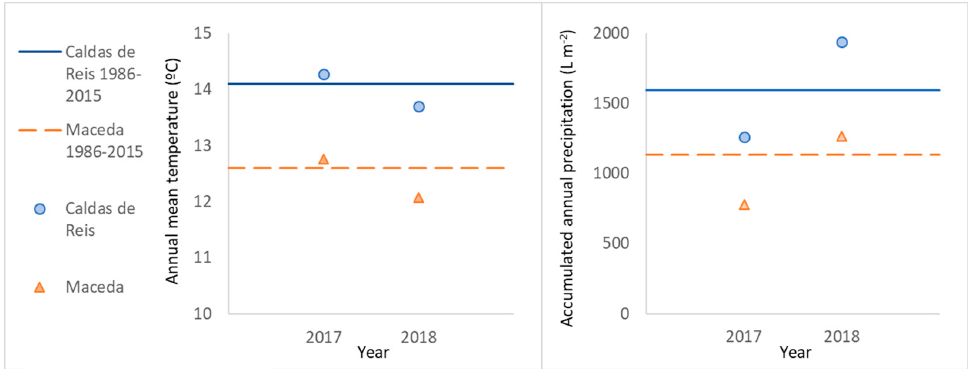
Figure 4. Annual mean temperature °C ( left ) and accumulated annual precipitation L m − 2 ( right ) in 2017 and 2018 in Caldas de Reis ( ● ) and Maceda ( ▲ ) (www.meteogalicia.gal, accessed on 3 August 2022). The horizontal lines indicate the reference climatic values for the period 1986–2015 in Caldas de Reis ( ̶ ) and Maceda (- -) (www.climatecharts.net, accessed on 3 August 2022).